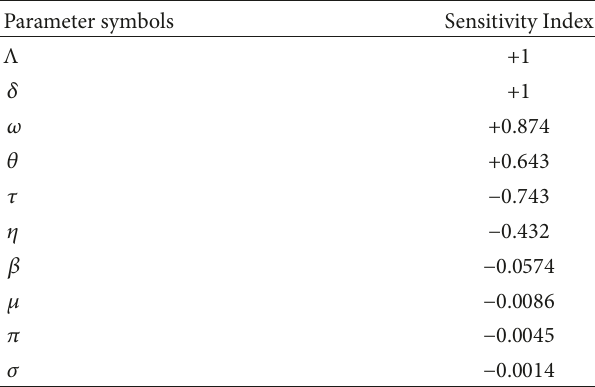
Table 1: Numerical values of sensitivity indices of R 𝑒